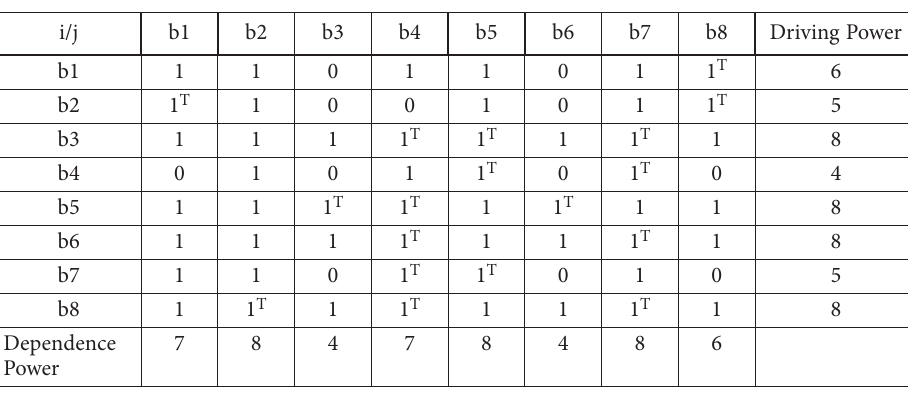
Table 3. Conclusive reachability matrix (CRM)